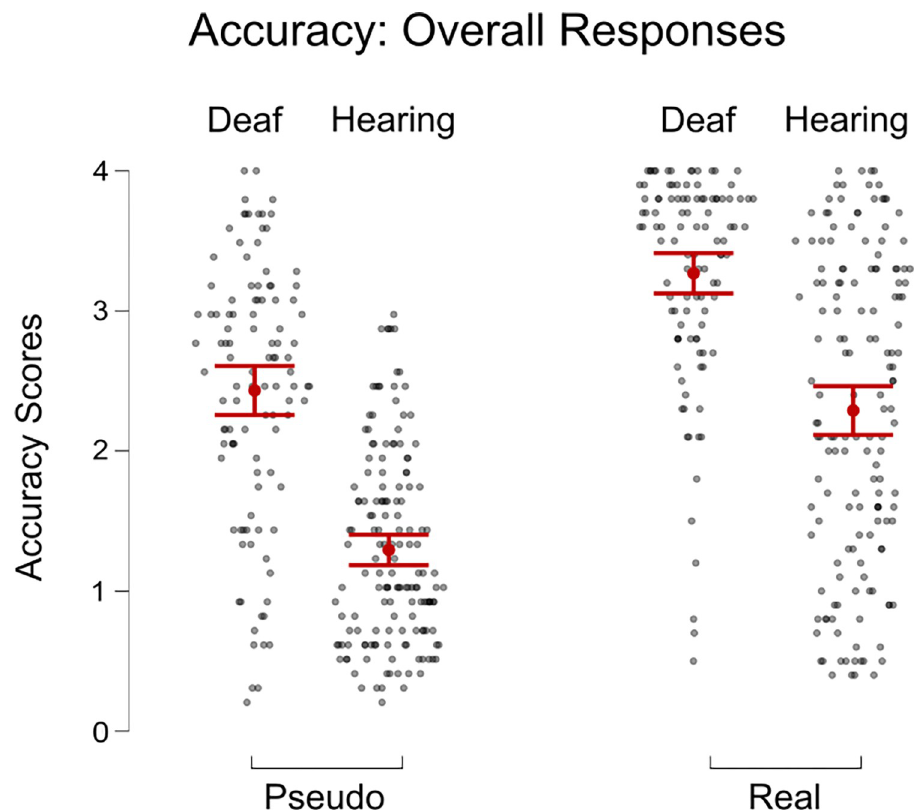
Fig 3. Overall mean accuracy of responses to pseudo and real place names for deaf and hearing groups. The error bars show standard error.